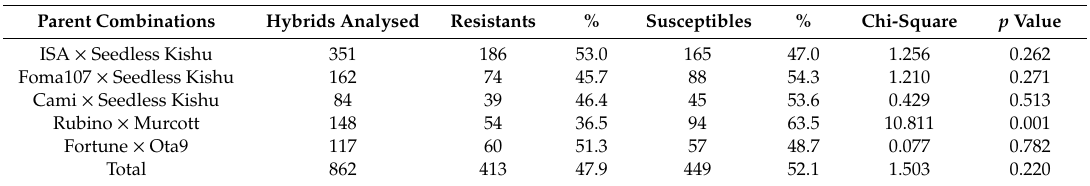
Table 4. Populations and total number of hybrids genotyped at the SNP08 locus using HRM, chi-square tests and P values for each